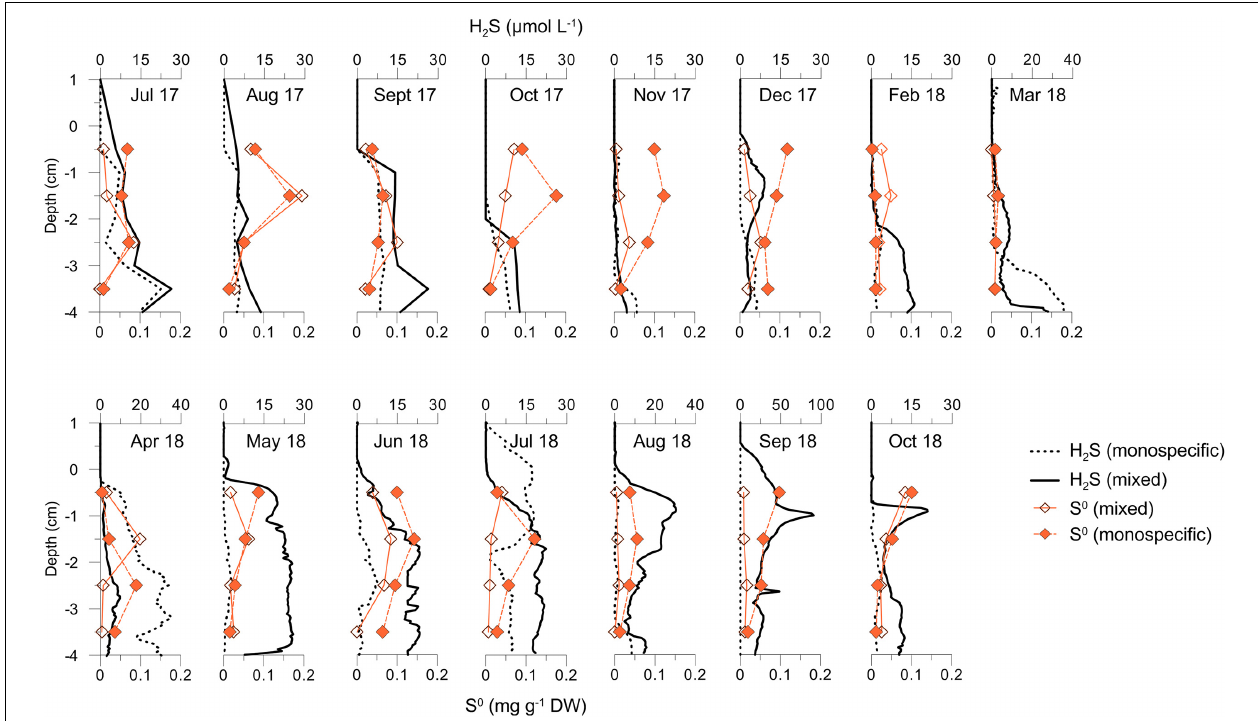
FIGURE 7 | Depth profiles of H 2 S and S 0 concentrations in sediments underlying mixed and C. cylindracea monospecific settlements during investigated